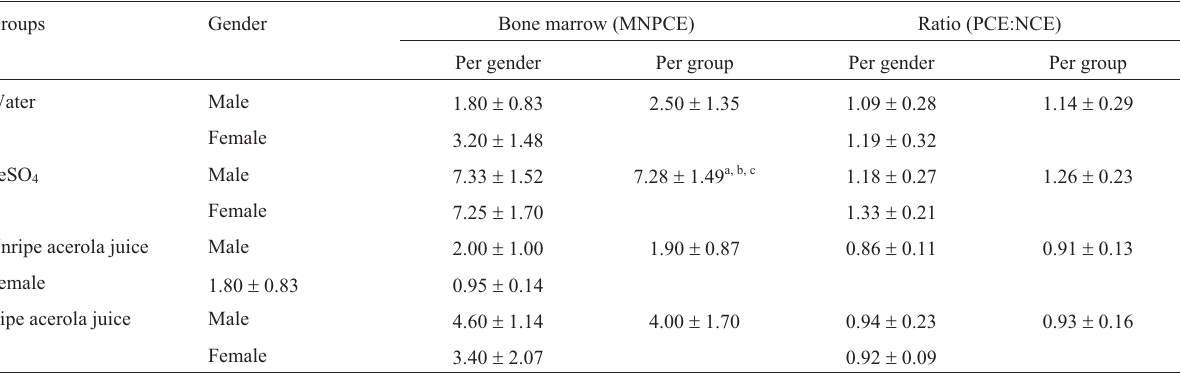
Table 3 - Detection of micronucleus mean ( (cid:3) standard deviation) in bone marrow polychromatic erythrocytes (MNPCE) of mice individuals exposed to acerola juice. Each group, n = 10 (five males and five females), with 2000 cells/animal.